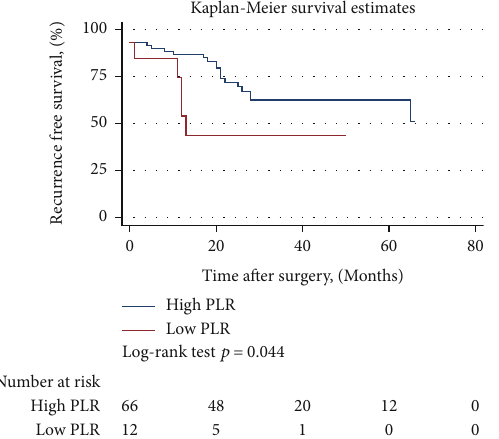
Figure 2: The Kaplan-Meier curve of RFS grouped by PLR. The low PLR group was signi fi cantly better than the high group ( P = 0 : 044 ) when the cut-o ff value was 266.70, suggesting PLR has a predictive value for Table 5: The Cox proportional hazards regression of OS and RFS. HR